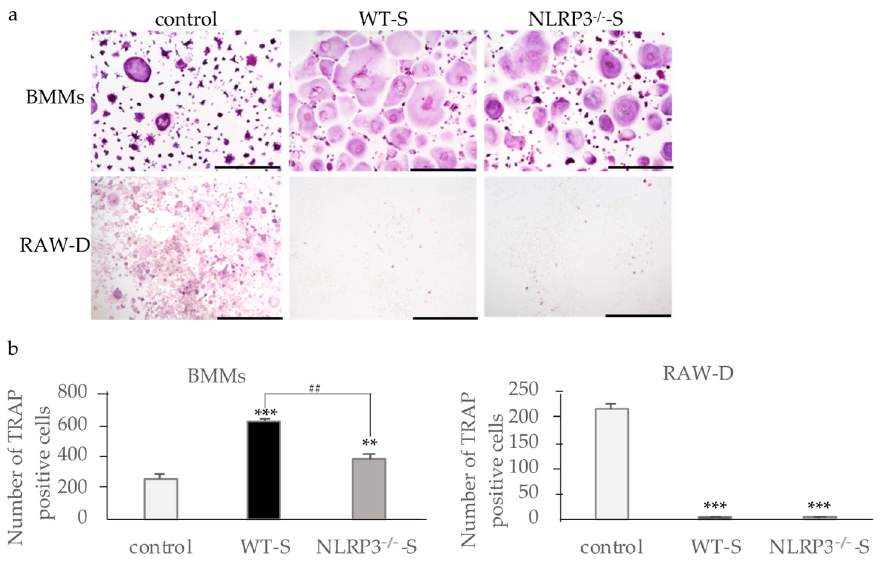
Figure 1. Effects of culture supernatants from mouse macrophages stimulated with dental calculus (DC) on osteoclastogenesis. BMMs were incubated with 30 ng/mL M-CSF and 20 ng/mL RANKL for 48 h. Then, the cells were incubated for 24 h with the same concentration of M-CSF, RANKL, and the culture supernatant from WT or NLRP3 − / − mouse macrophages stimulated with DC. RAW-D cells were incubated with 20 ng/mL RANKL for 48 h. The cells were then incubated for 48 h with the same concentration of RANKL and the culture supernatant from WT or NLRP3 − / − mouse macrophages stimulated with DC. These cells were subjected to TRAP staining ( a ), and TRAP-positive cells with more than three nuclei were counted ( b ). Scale bar = 500 μ m. The differences between the groups were analyzed by one-way ANOVA followed by a Tukey test for multiple comparisons. ** p < 0.01 *** p < 0.001 compared with the control. ## p < 0.01 compared among the test groups. BMM, bone marrow macrophages; DC, dental calculus; M-CSF, macrophage colony-stimulating factor; NLRP3 − / − -S, culture supernatant of the NLRP3-deficient mouse macrophages stimulated with DC; WT, wild-type; WT-S, culture supernatant of the wild-type mouse macrophages stimulated with DC.